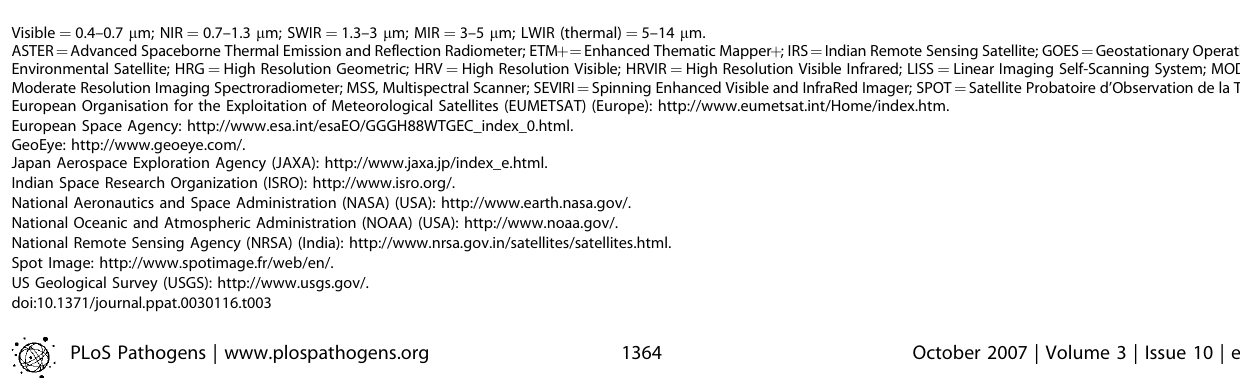
Environmental Satellite; HRG ¼ High Resolution Geometric; HRV ¼ High Resolution Visible; HRVIR ¼ High Resolution Visible Infrared; LISS ¼ Linear Imaging Self-Scanning System; MODIS ¼ Moderate Resolution Imaging Spectroradiometer;MSS, MultispectralScanner; SEVIRI ¼ Spinning Enhanced Visibleand InfraRed Imager; SPOT ¼ Satellite Probatoire d’Observation de la Terre. European Organisation for the Exploitation of Meteorological Satellites (EUMETSAT) (Europe): http://www.eumetsat.int/Home/index.htm. European Space Agency: http://www.esa.int/esaEO/GGGH88WTGEC_index_0.html. GeoEye: http://www.geoeye.com/. Japan Aerospace Exploration Agency (JAXA): http://www.jaxa.jp/index_e.html. Indian Space Research Organization (ISRO): http://www.isro.org/. National Aeronautics and Space Administration (NASA) (USA): http://www.earth.nasa.gov/. National Oceanic and Atmospheric Administration (NOAA) (USA): http://www.noaa.gov/. National Remote Sensing Agency (NRSA) (India): http://www.nrsa.gov.in/satellites/satellites.html. Spot Image: